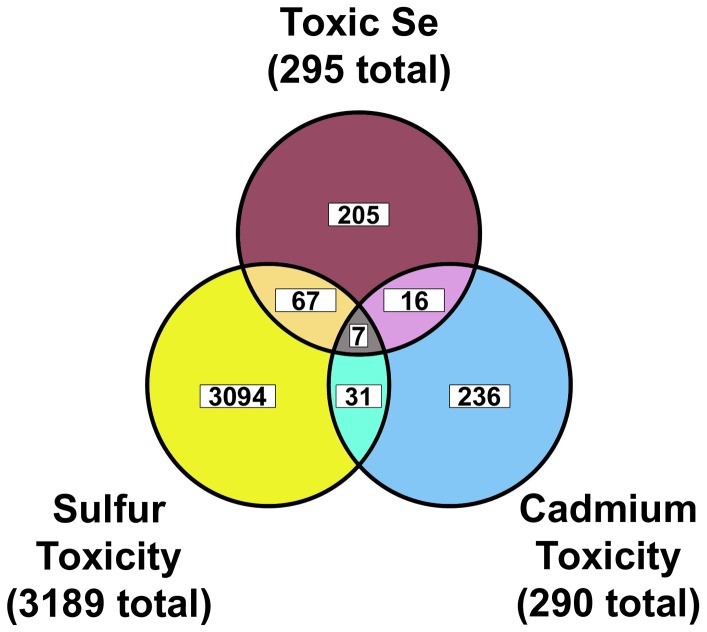
Identification of “toxic-Se specific” transcript dataset.The 295 overlapping toxic-Se transcripts in (0.2 and 0.4 vs. 0.1 mM Se) were filtered to remove the 67 transcripts that overlapped with transcripts changed ≥2-fold by sulfur toxicity [33], to remove the 16 transcripts that overlapped with transcripts changed ≥2-fold by cadmium toxicity [34], and to remove the 7 transcripts found in all sets, resulting in 205 transcripts. Removal of 23 duplicate transcripts resulted in the dataset of 182 “toxic-Se specific” genes.